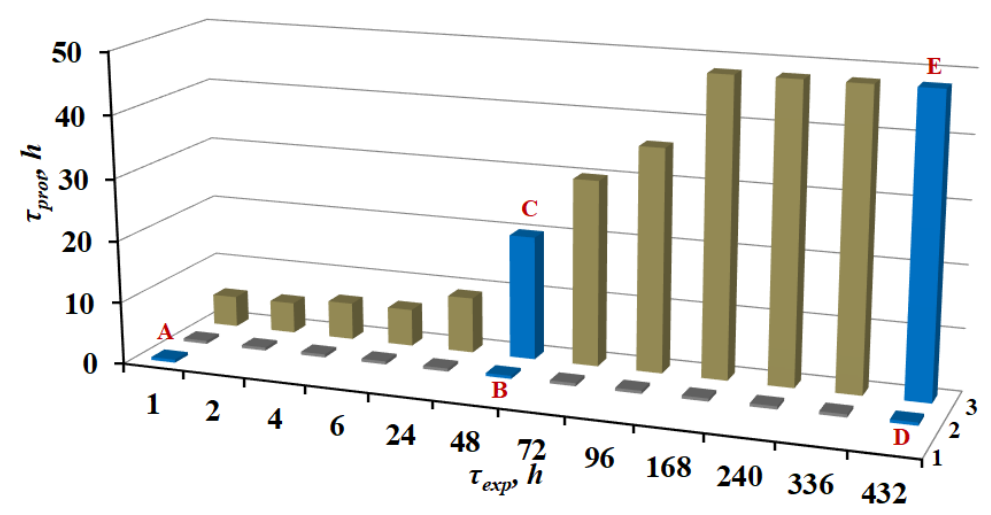
Figure 2. Effect of τ exp on the τ prot of magnesium alloy samples treated under different conditions. Row 1—neither TT nor CT; row 2—after TT; row 3—after CT. The results obtained for the samples prepared in modes A , B , C , D , and E are highlighted in color.